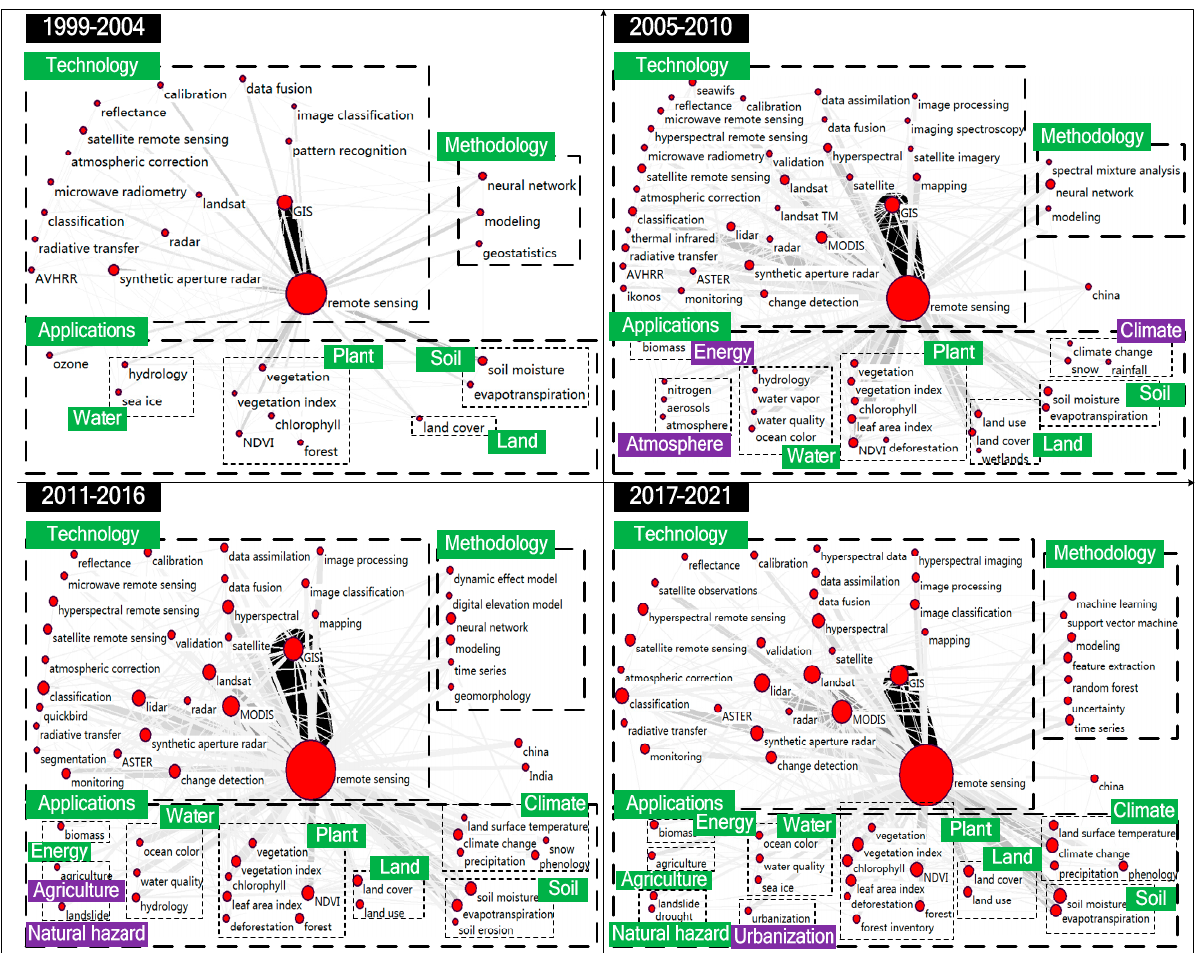
Figure 4. The interconnection network and evolution of keywords in remote-sensing-related publi- cations during 1999–2021. The red dot represents the relative number of keywords. The larger the red dot is, the more frequently the keyword appears in the related literature. The pattern of the grey line presents the number of co-occurrences. The thicker and darker the line is, the larger the number of co-occurrences of keywords that were used by the author.